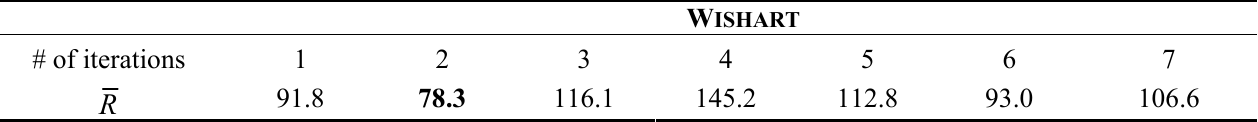
Table 1. Averaged separability values for the Wishart classifier against the number of iterations. W ISHART